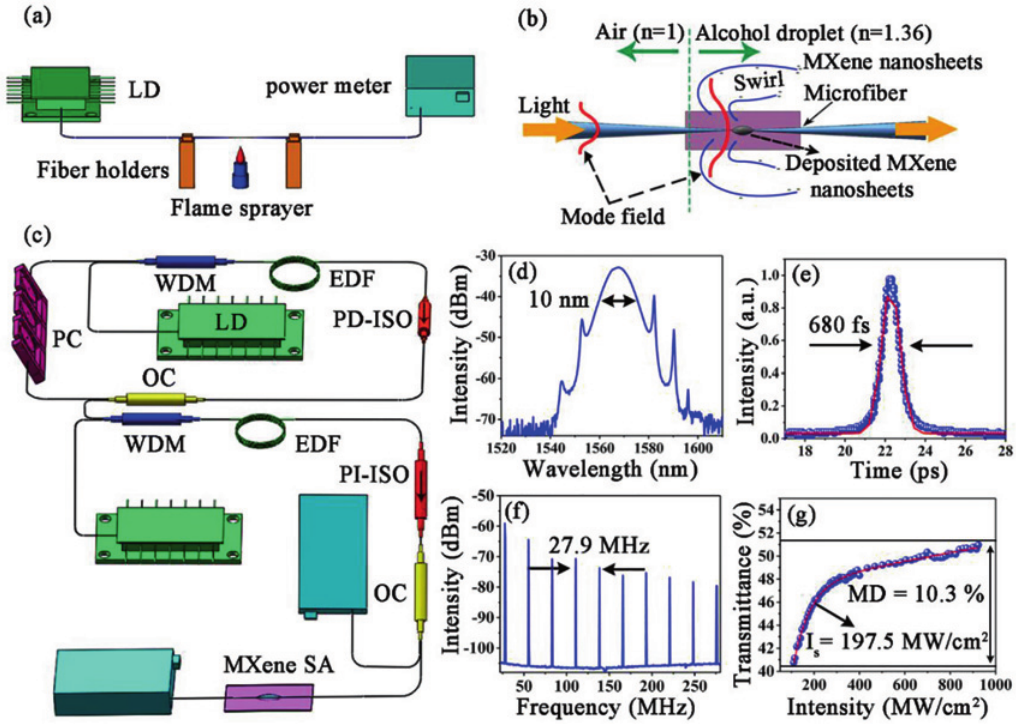
Figure 2: (a) Experimental setup for fabricating of microfiber. (b) Schematic of optical deposition. (c) Detector system of the nonlinear absorbance.(d)Outputspectrumofseedlight.(e)Autocorrelationmapofseedlightpulse.(f)Radiofrequencyspectrumofseedlightpulse.(g) Nonlinear transmittance curve (the blue and red curves represent the experimental and fitting results